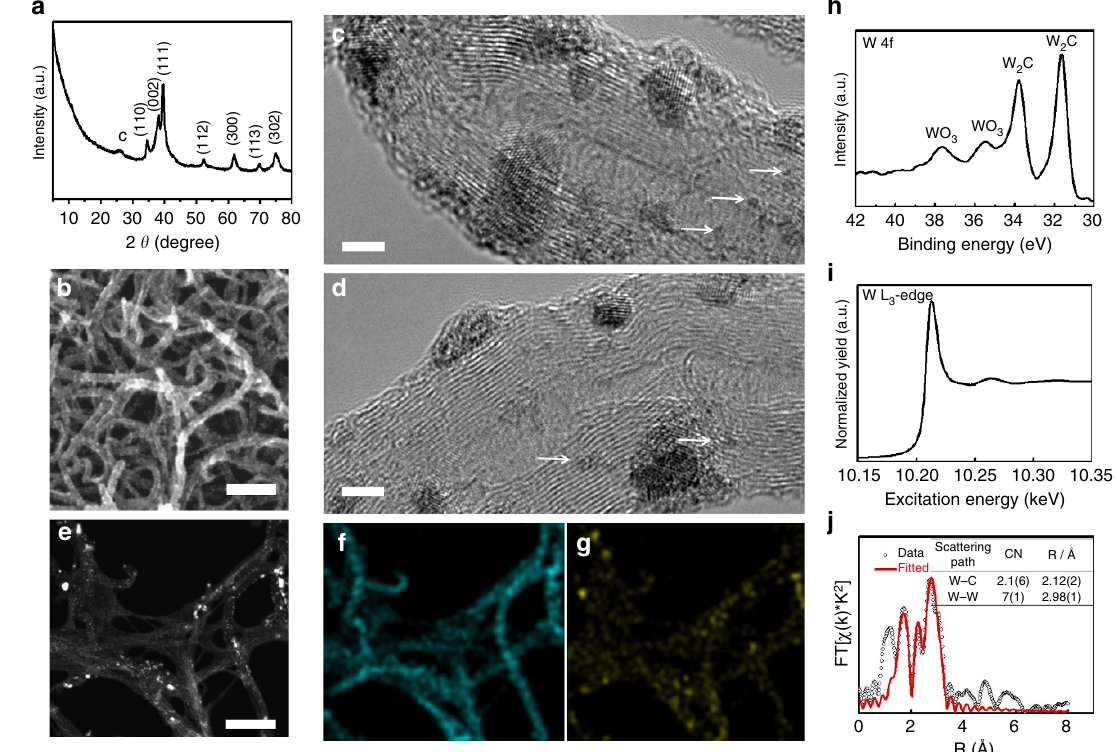
Figure 3 | Microscopic and spectroscopic characterizations of W 2 C nanoparticles supported on MWNTs. ( a ) X-ray diffraction pattern, ( b ) SEM image and ( c , d ) TEM images of W 2 C/MWNT. ( e ) HAADF image and ( f , g ) corresponding C and W EDS element mapping of W 2 C/MWNT. ( h ) W 4f XPS spectrum, ( i ) W L 3 -edge XANES spectrum and ( j ) Fourier transform EXAFS spectrum and associated fitting curve of W 2 C/MWNT at the W L 3 -edge. The inset in j shows the fitting results. Scale bar, 100nm ( b , e ); 3nm ( c , d